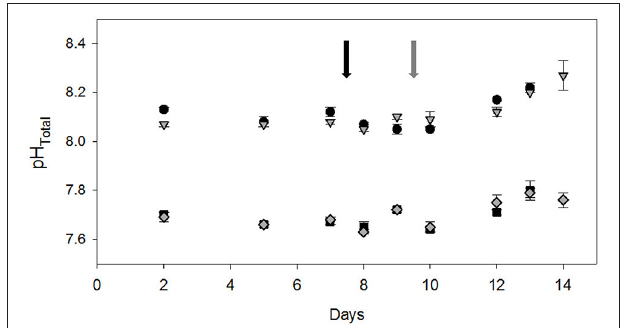
FIGURE 2 | Development of pH total in LL LC (black circles), LL HL (black squares), HL LC (gray triangles), and HL HC (gray diamonds) treatments over the course of the incubation experiment ( n = 3 ± errors bars indicate 1 s.d.). The arrows indicate the time of dilution for LL (black) and HL (gray) treatments.